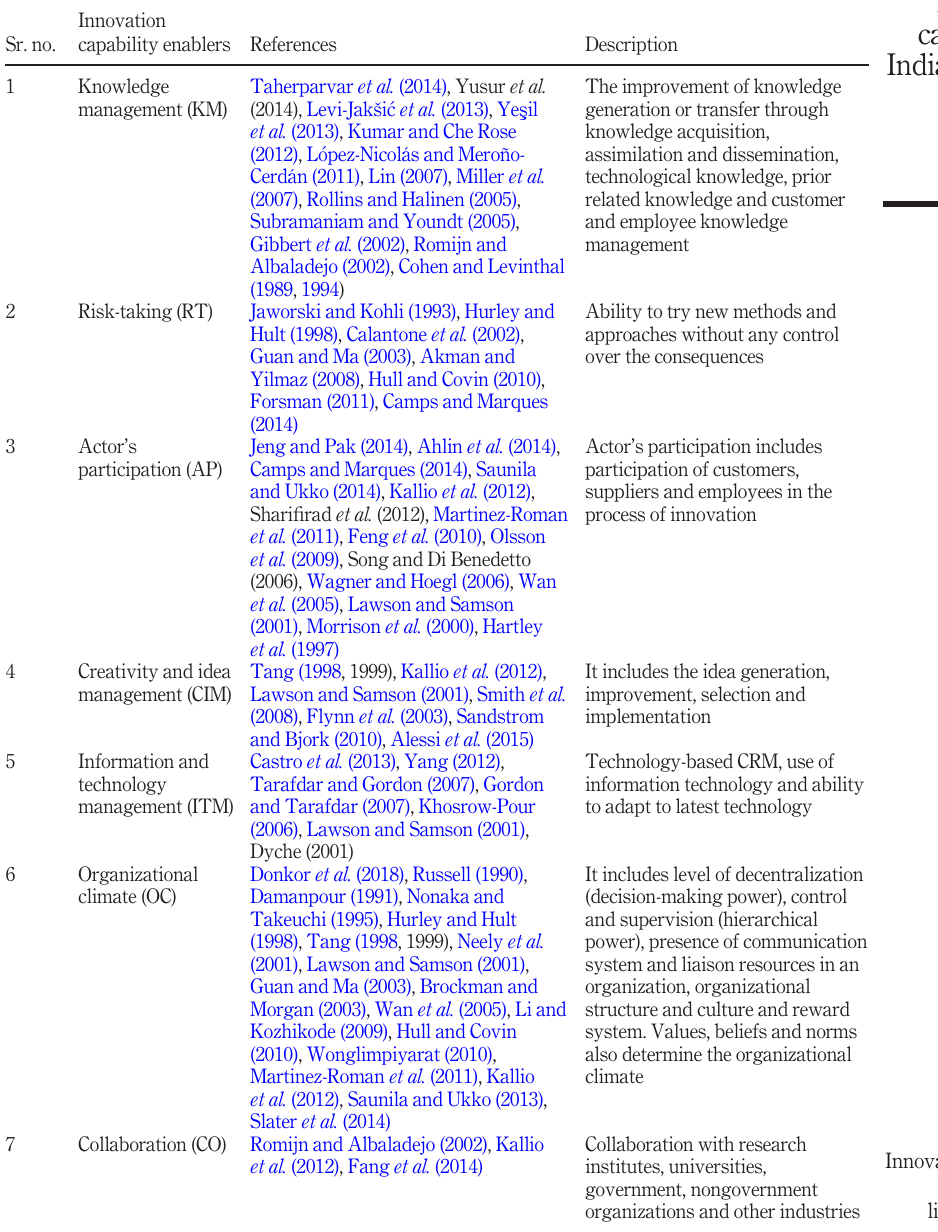
Table I. Innovation